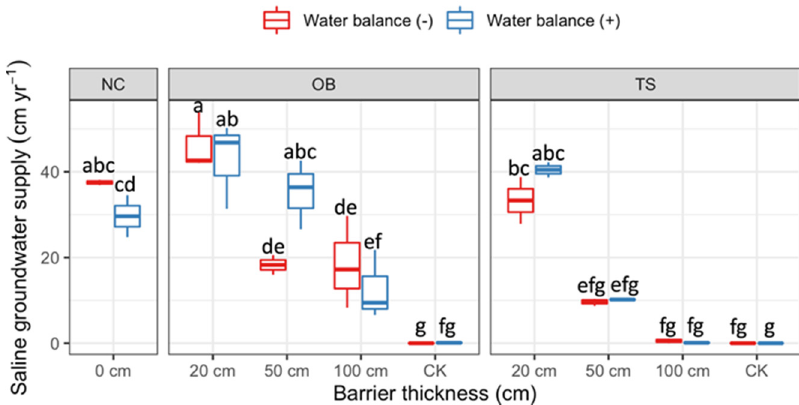
Figure 3. Saline groundwater up-flux during 3 growing seasons. Different letters indicate significant differences ( p < 0.05, ANOVA) among treatments, which were derived by comparing all the values across the NC, OB and TS trials.